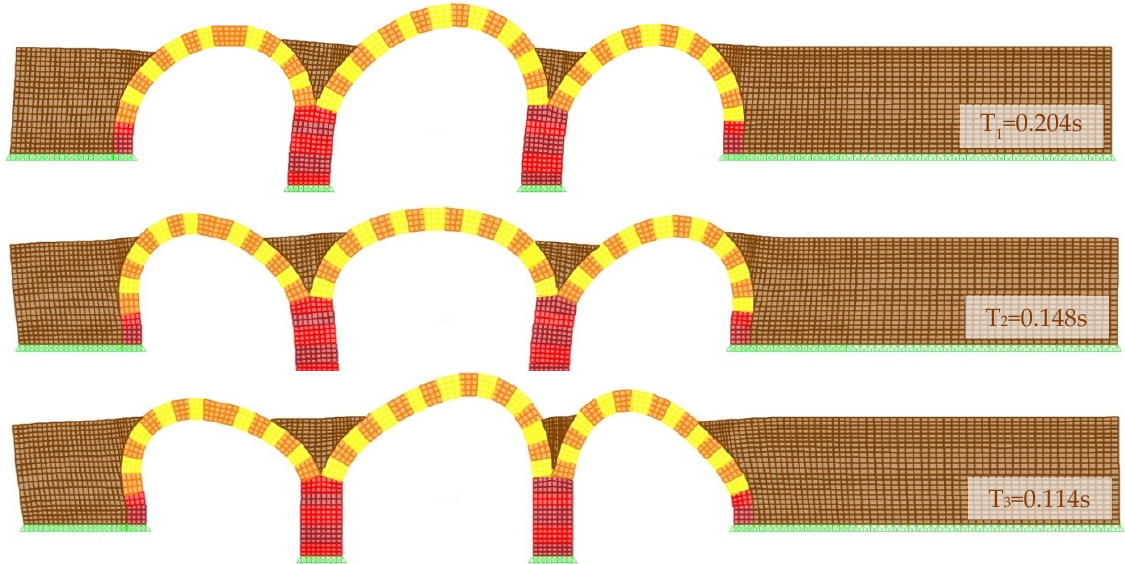
Figure 11. Modal analysis results for the existing bridge. The results of the nonlinear dead load analysis under the self-weight of the bridge